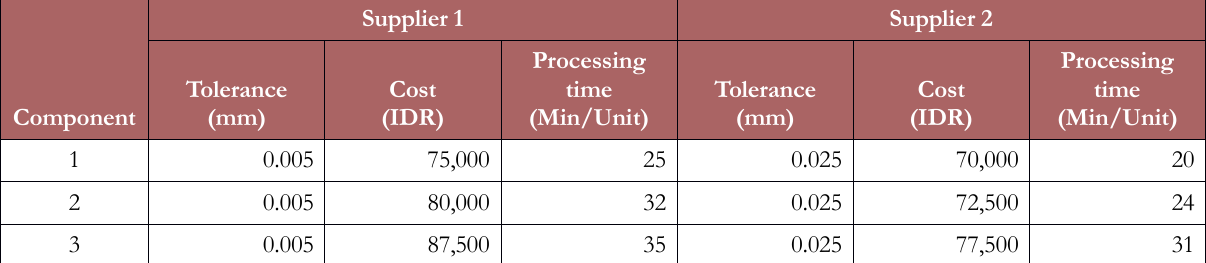
Table 3. Suppliers characteristics